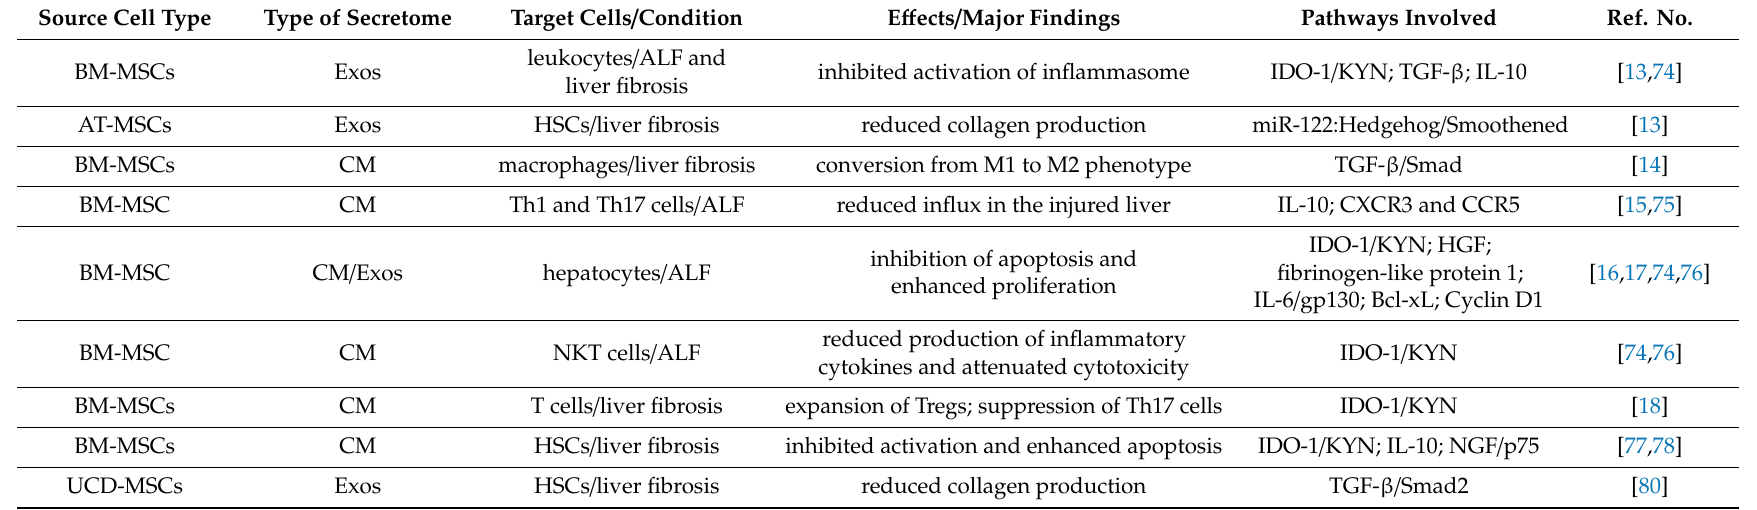
Table 1. Therapeutic potential of MSC-derived secretome in liver